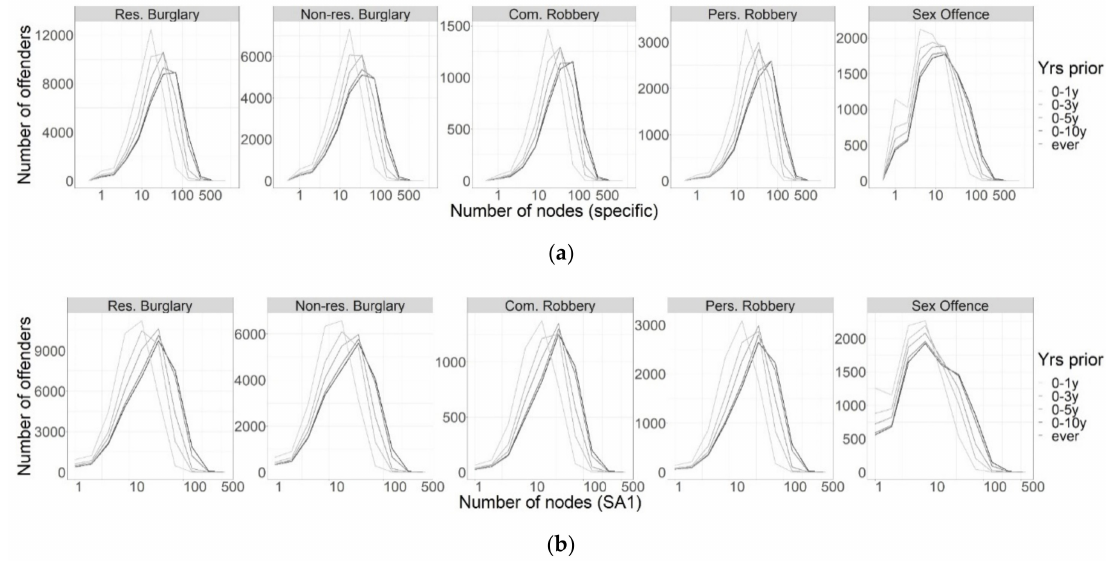
Figure 2. Distribution of activity nodes per offender by reference offense type and timeframe preceding the reference offense based on specific coordinates ( a ) and SA1 census units ( b